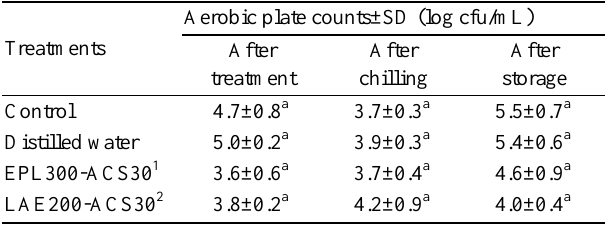
Table 3. Mean aerobic plate counts on chicken carcasses after spray treatment with distilled water, EPL300-ACS30 or LAE200- ACS30, after chilling and after 10 days of storage at 4.4°C